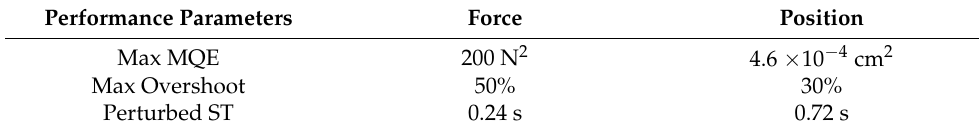
Table 2. Controllers performance: Mean Quadratic Error (MQE), Overshoot, Settling Time (ST). Performance